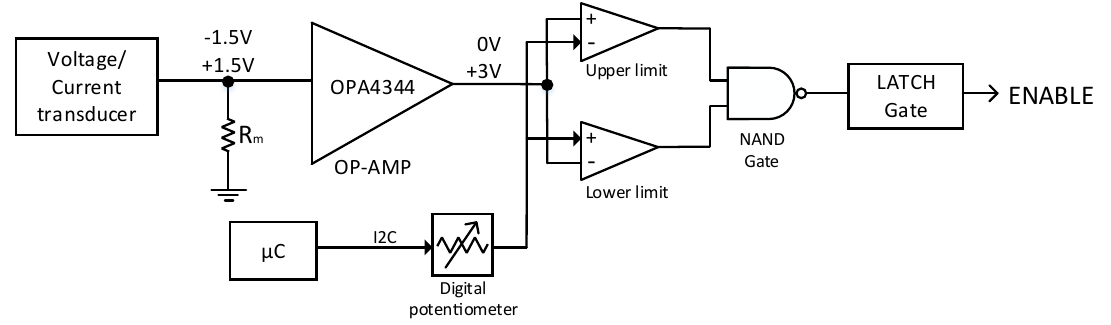
Figure 4. Electrical protection based on comparators and logic